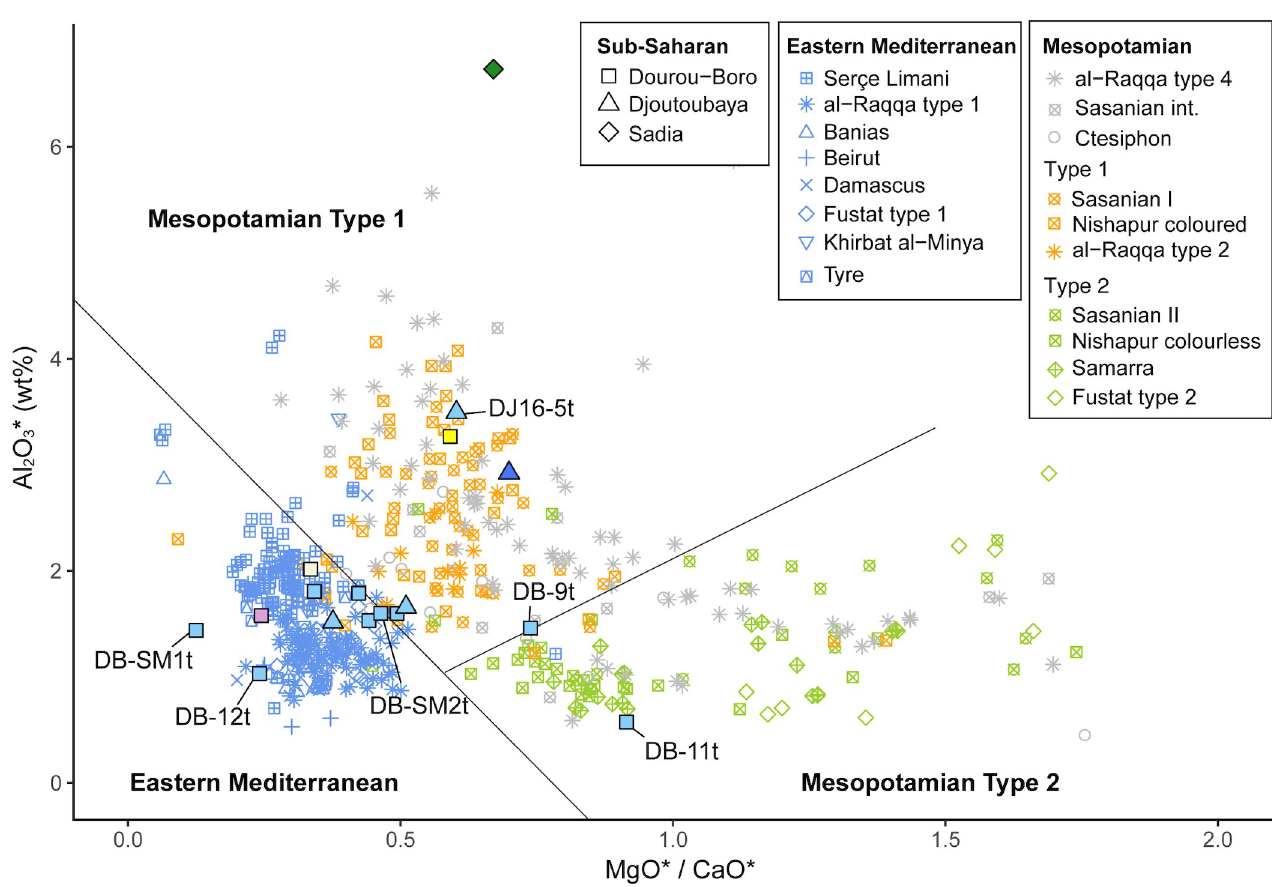
Fig 11. Dourou-Boro, Djoutoubaya, and Sadia glasses compared to contemporary glass assemblages. Alumina versus magnesia to lime ratios of published data of glasses from Levantine and Mesopotamian contemporary sites, grouped after Phelps [49, 50].